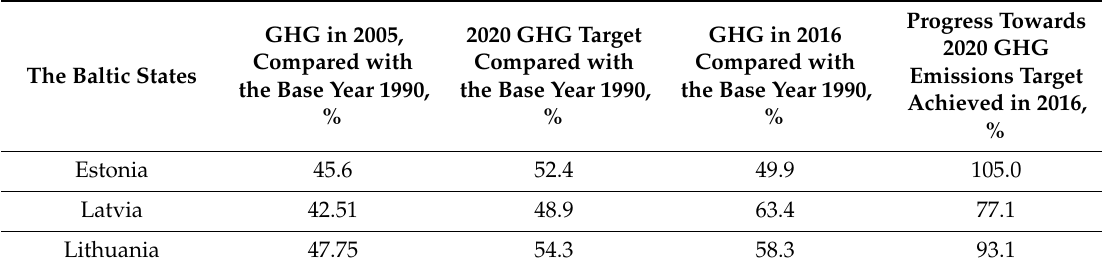
Table 4. National GHG emission reduction targets for the Baltic States in 2020 and results achieved in 2005 and in 2016. Source: created by the authors based on